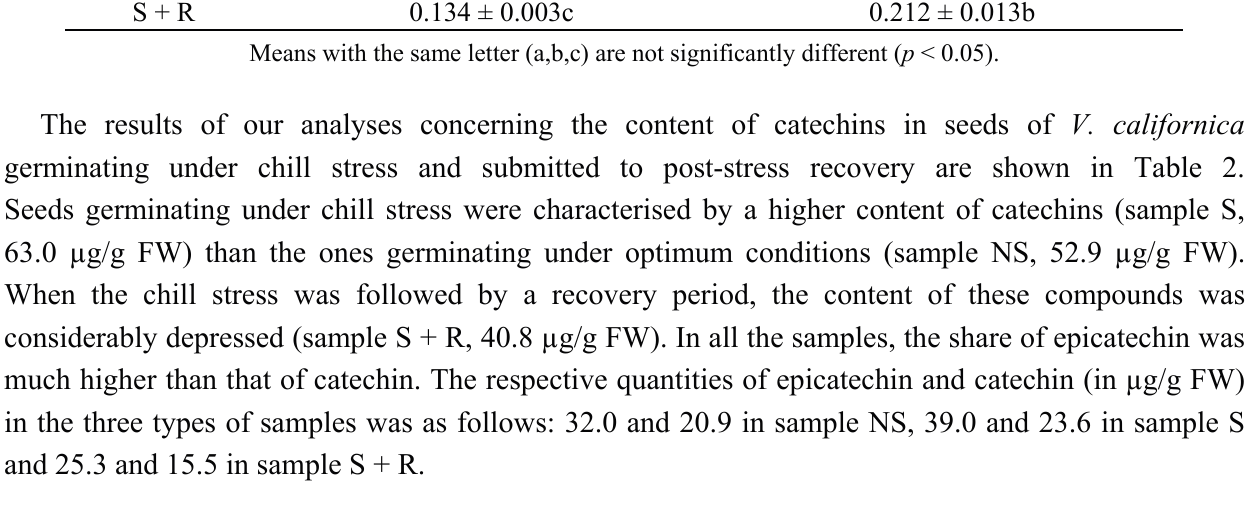
Table 2. Content of catechins in seeds ( μ g/g